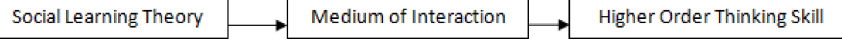
Figure 1. Basic flow from social learning theory to promote higher order thinking skill